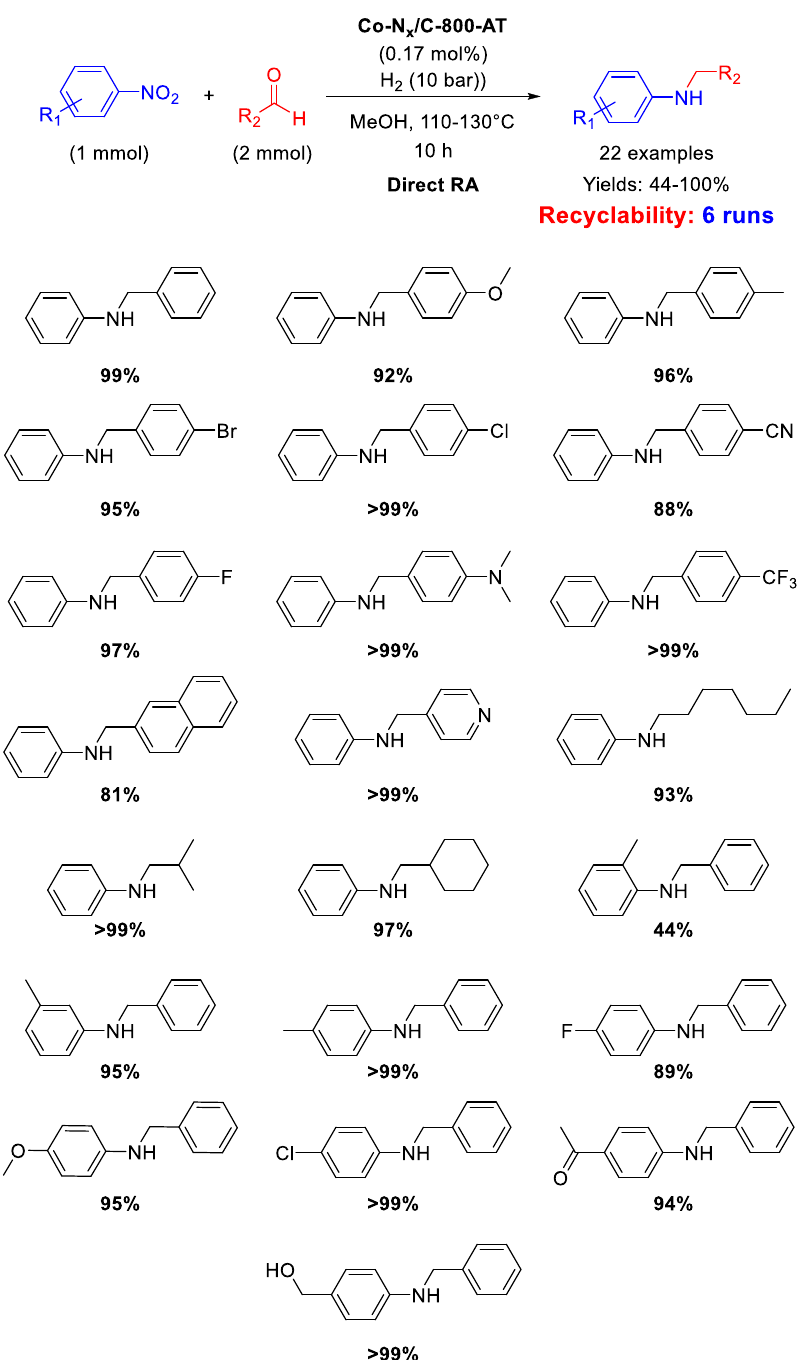
Scheme 43. DRA catalyzed by Co-N x /C-800-AT under 10 bar H 2 On the basis of the above reported results, in the second part of 2017, Zhang’s group synthesized another catalyst by pyrolysis at 600 °C for 3 h under N 2 of cobalt supporting zeolitic imidazolate-frameworks (ZIF-67)/graphene oxide (GO) composite (ZIF-67/GO), followed by acid-etching with H 2 SO 4 , aiming to remove Co NPs formed under calcination [98]. Differently from the Co-N x /C-800-AT material, in this case the acid washing was able